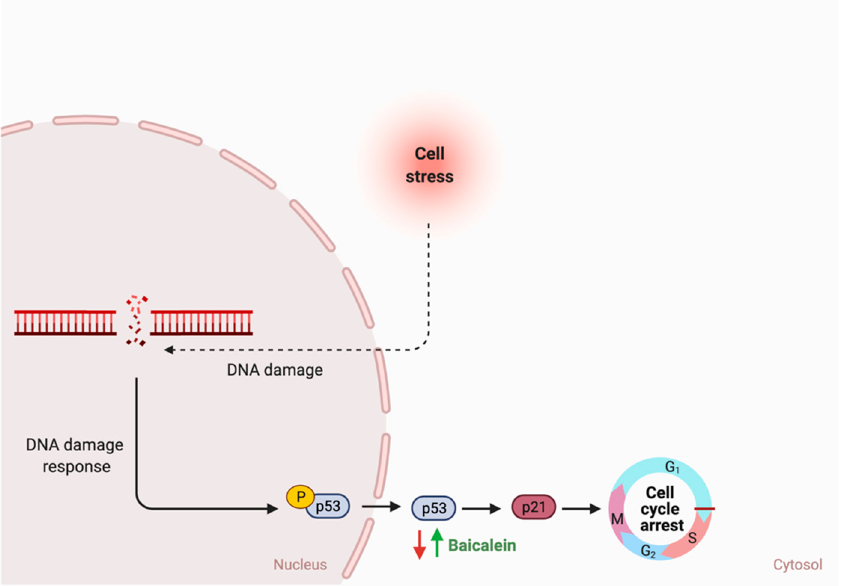
Figure 9. Schematic illustration of the impact of flavonoids on cell cycle arrest. Red arrows represent the effects of GI cancer on the pathway, while the green arrows illustrate the impact of flavonoids on the pathway. Created with BioRender.com (accessed on 3 August